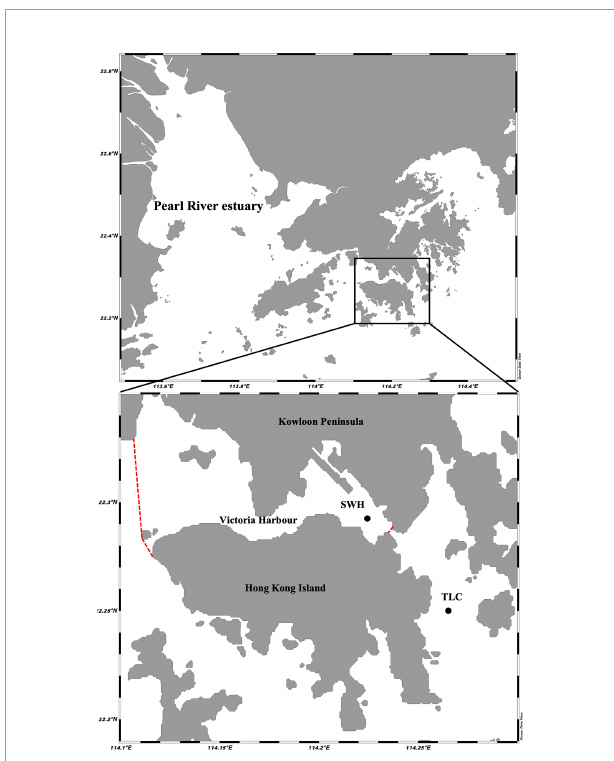
FIGURE 1 | Map showing the relatively unpolluted site TLC and organically enriched site SWH in subtropical Hong Kong, the red dotted lines indicate the boundary of Victoria